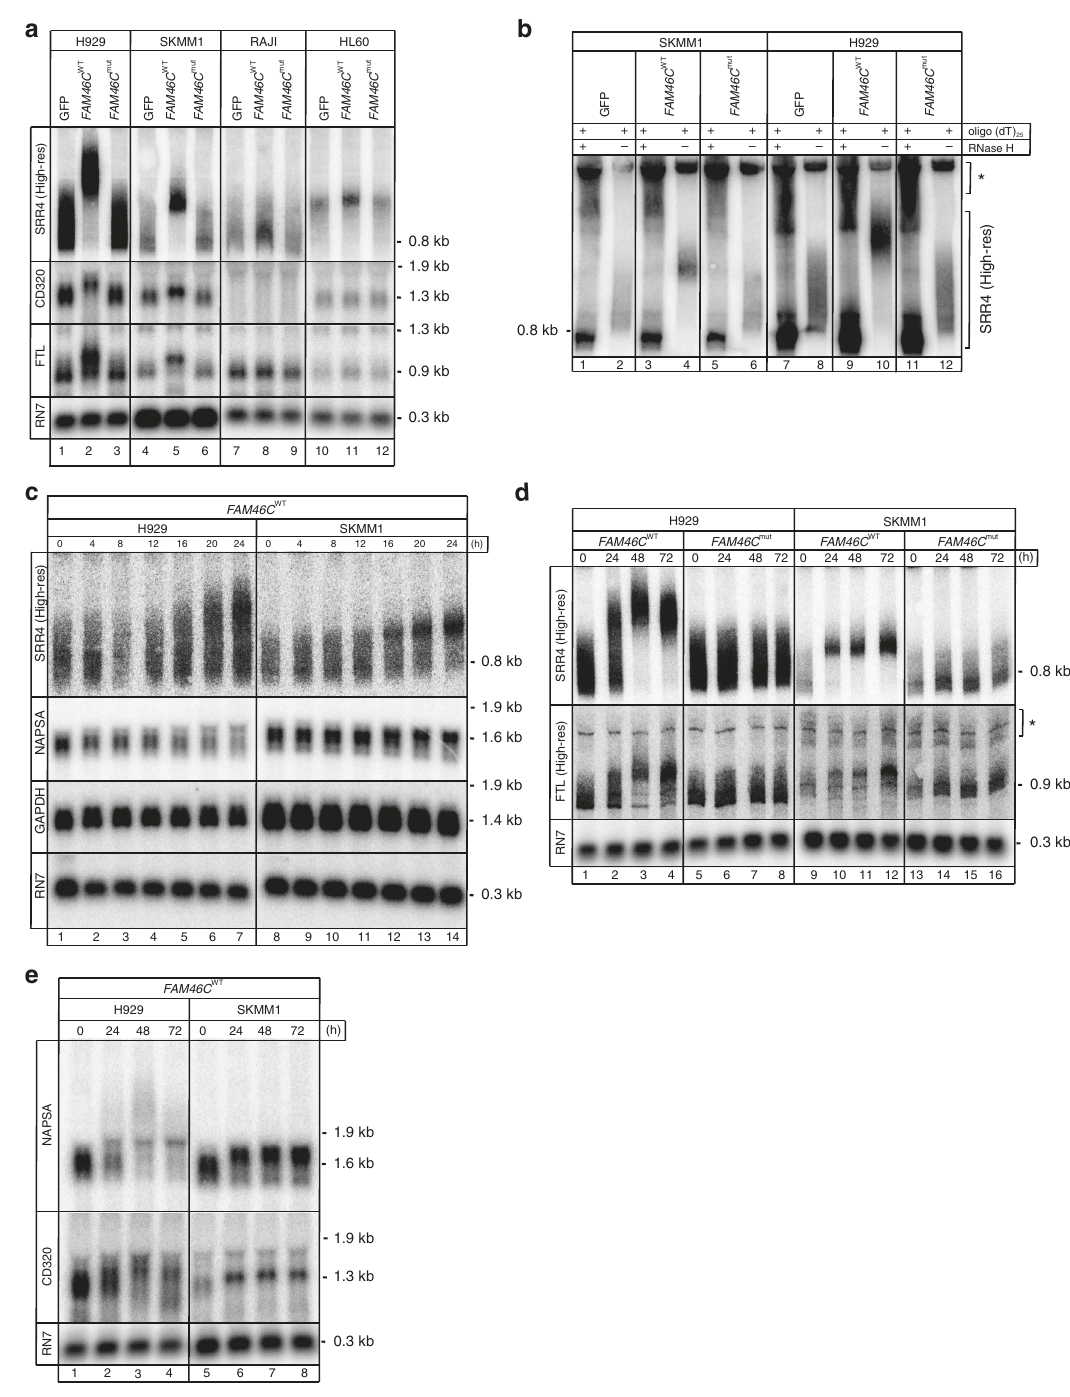
Fig. 8 FAM46C expression results in polyadenylation of selected mRNAs in MM cells. a Northern blot analysis of SSR4 , CD320 , and FTL transcripts from H929 (lanes 1 – 3), SKMM1 (lanes 4 – 6), Raji (lanes 7 – 9) and HL60 (lanes 10 – 12) cells transduced with GFP (lanes 1, 4, 7, 10), FAM46C WT -GFP (lanes 2, 5, 8, 11), and FAM46C mut -GFP (lanes 3, 6, 9, 12). Asterisks indicate cross-hybridization signals. b The SSR4 transcript is extensively polyadenylated by FAM46C in MM cells. High-resolution northern blot analysis of SSR4 transcripts from SKMM1 (lanes 1 – 6) and H929 (lanes 7 – 12) transduced with GFP (lanes 1, 2, 7, 8), FAM46C WT -GFP (lanes 3, 4, 9, 10), and FAM46C mut -GFP (lanes 5, 6, 11, 12) after RNase H treatment (lanes 1, 3, 5, 7, 9, 11) to remove the poly(A) tail in presence of oligo(dT) 25 . Control reactions were carried out in the presence of oligo(dT) without RNase H (lanes 2, 4, 6, 8, 10, 12). Kinetics of polyadenylation of SSR4 , NAPSA , FTL , and CD320 transcripts over the time course of FAM46C expression. c High- and low-resolution northern blot analysis of SSR4 , NAPSA , GAPDH , and RN7 transcripts from H929 (lanes 1 – 7) and SKMM1 cells (lanes 8 – 14) transduced with FAM46C WT -GFP up to 24 h. d High- resolution northern blot analysis of SSR4 and FTL transcripts from H929 (lanes 1 – 8) and SKMM1 cells (lanes 9 – 16) transduced with FAM46C WT -GFP (lanes 1 – 4, 9 – 12) and FAM46C mut -GFP (lanes 5 – 8, 13 – 16) up to 72 h. e Northern blot analysis of NAPSA and CD320 transcripts from H929 (lanes 1 – 4) and SKMM1 cells (lanes 5 – 8) transduced with FAM46C WT -GFP up to 72 h